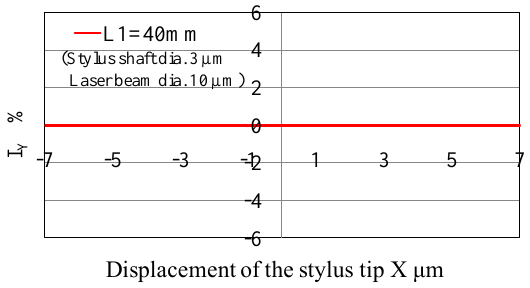
Fibers 2016 , 4 , 24